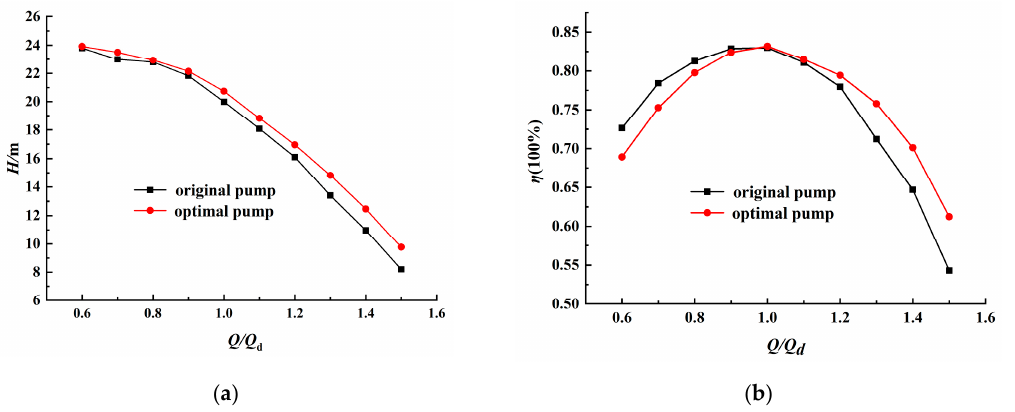
Figure 8. Head and efficiency of original pump and optimal pump. ( a ) Q - H ; ( b ) Q - η .